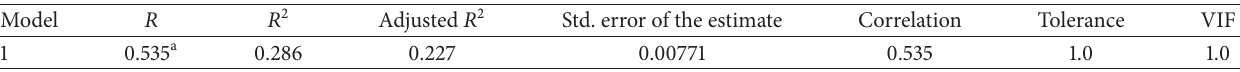
Table 2: Collinearity